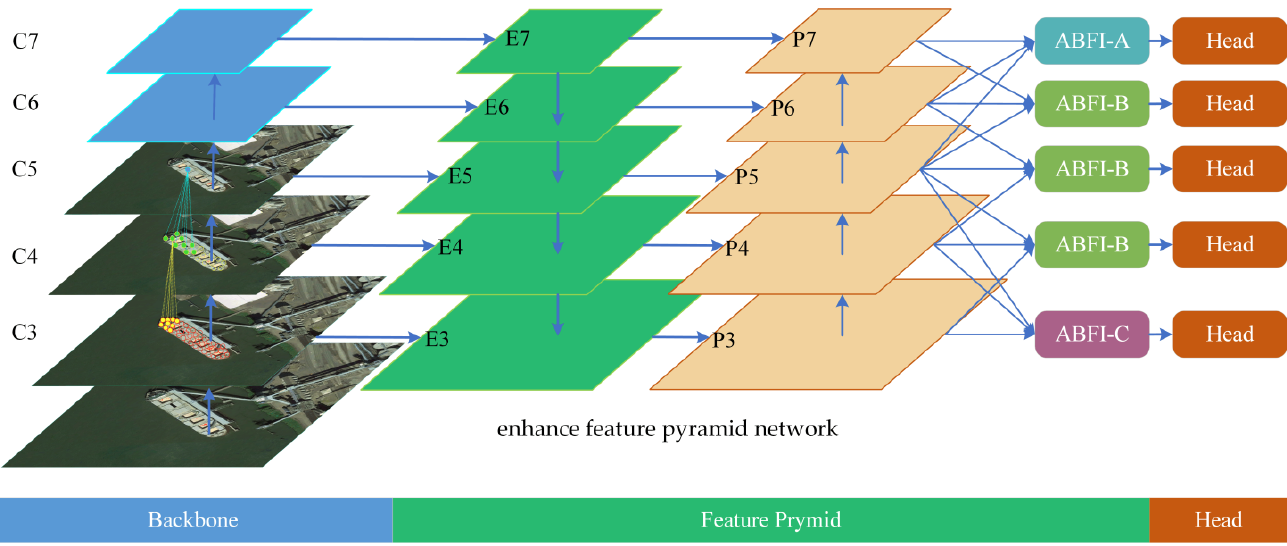
Figure 3. The framework of the proposed FD-Net. FD-Net consists of four main components: the backbone uses the ResNet-50 and deformable convolution to extract features, an enhanced feature pyramid network (EFPN) based on PANet and deformable convolution for multi-scale feature fusion, an adaptive balanced feature integrated (ABFI) module and the VFNet head.